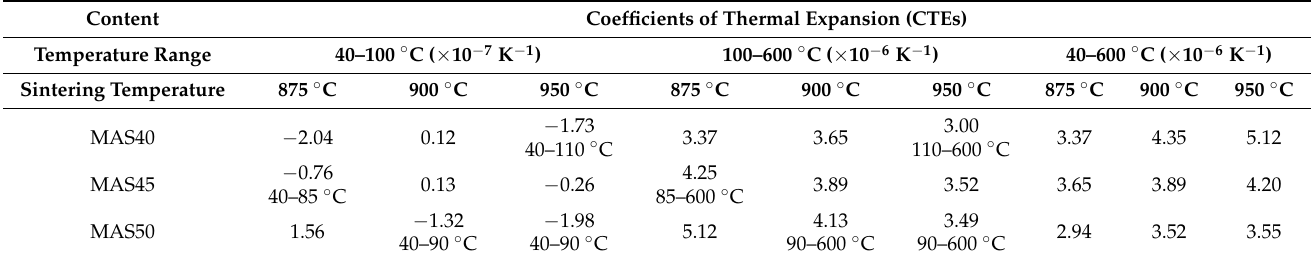
Figure 7. Thermal expansion behavior of the glass-ceramics prepared at different sintering temperatures. Table 4. The values of the linear coefficients of thermal